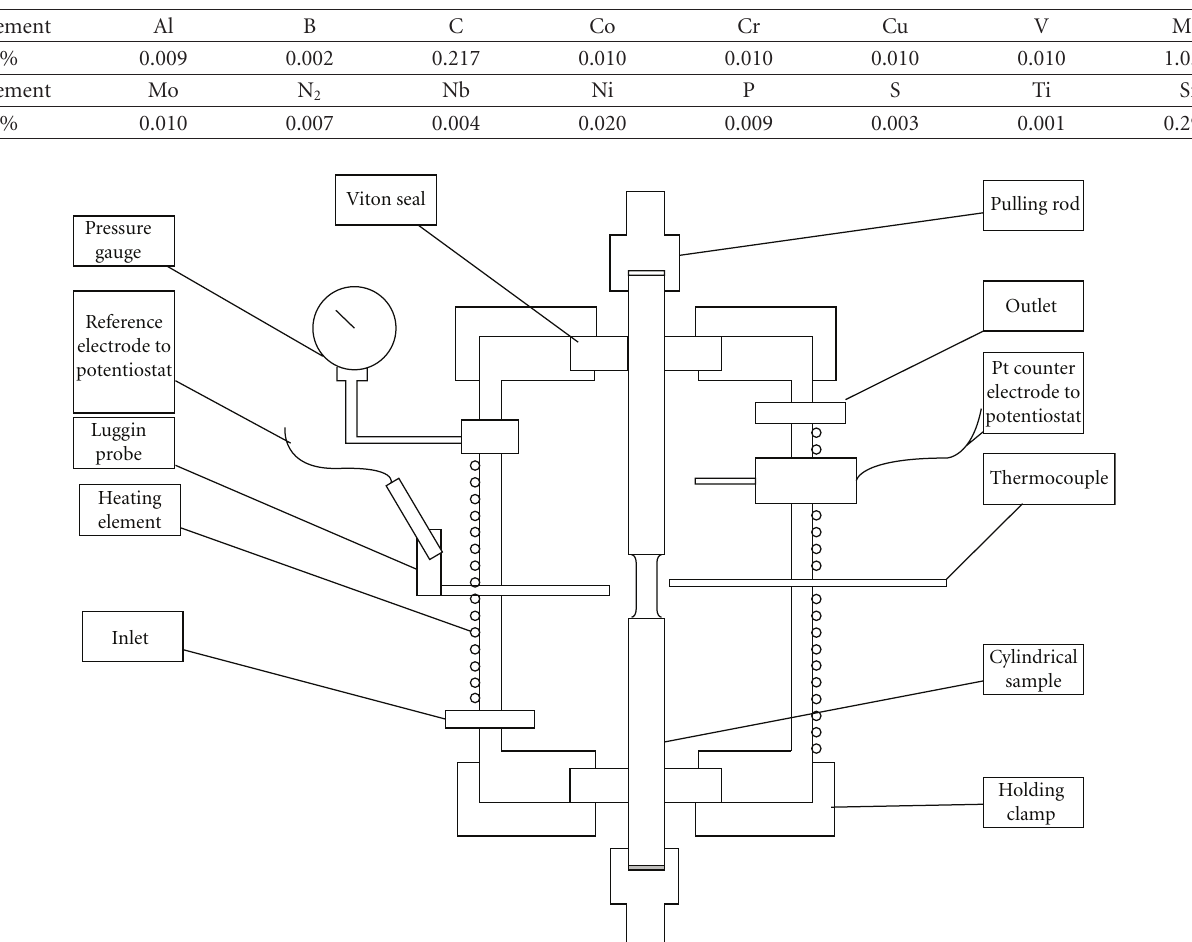
Figure 1: A schematic presentation of the tensile specimen in the autoclave that was used for the slow strain-rate